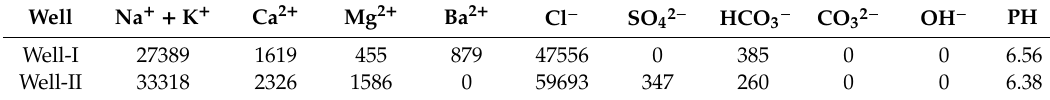
Table 1. Ion content of formation water from southwest China, mg / L.